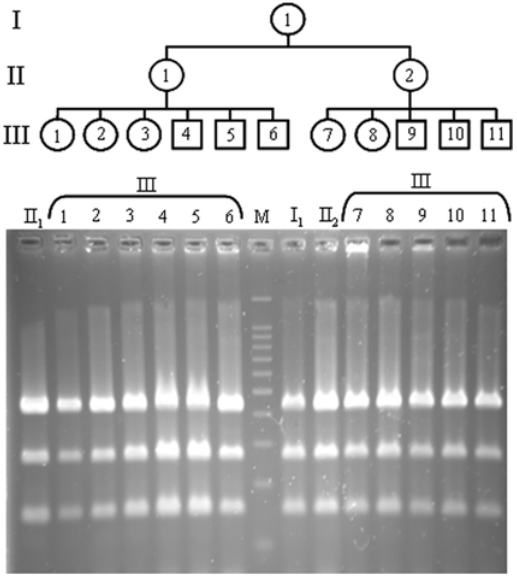
Figure 2. Stable inheritance of the 11973G/A heteroplasmy across three generations (I–III) of an Armadillidium vulgare maternal lineage (top). HpyCH4V digestion profiles showing that all individuals carry the 119973G/A heteroplasmy (bottom). M: 100 bp molecular ladder (BenchTop, Promega).